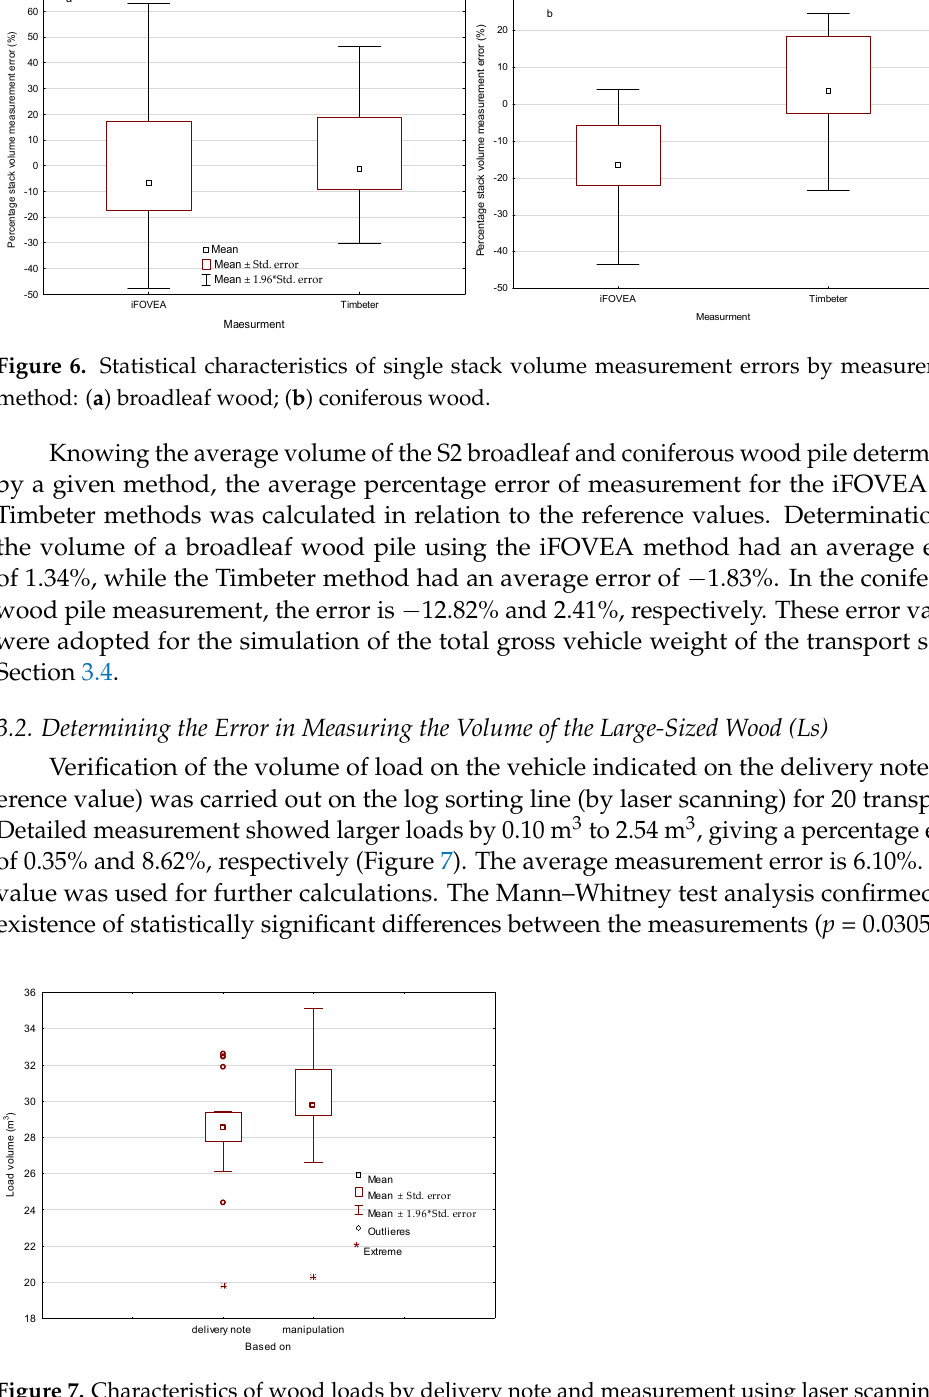
Table 3. Characteristic of wood deliveries parameters. Measure